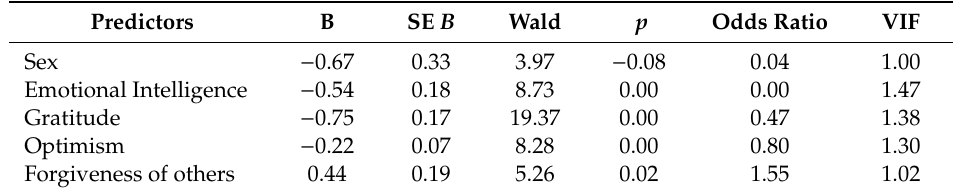
Table 4. Distinction between depressive symptomatology ( n = 89) and non-depressive symptomatology ( n = 162) group membership: final logistic regression analysis. Predictors B SE B